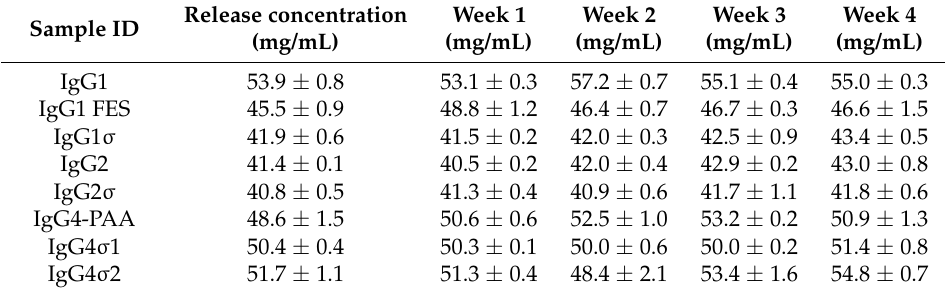
Table 3. Stability of Concentrated Proteins Stored at 4 ◦ C (concentration of antibodies over time).